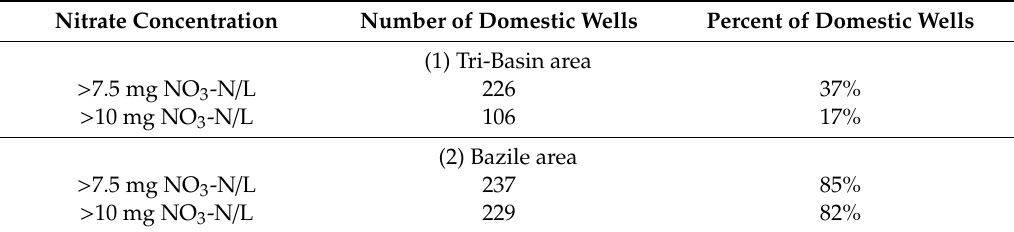
Table 3. Estimated number of wells exceeding 7.5 mg NO 3 -N/L and 10 mg NO 3 -N/L threshold under intensive cropping systems from 2009 to 2015.